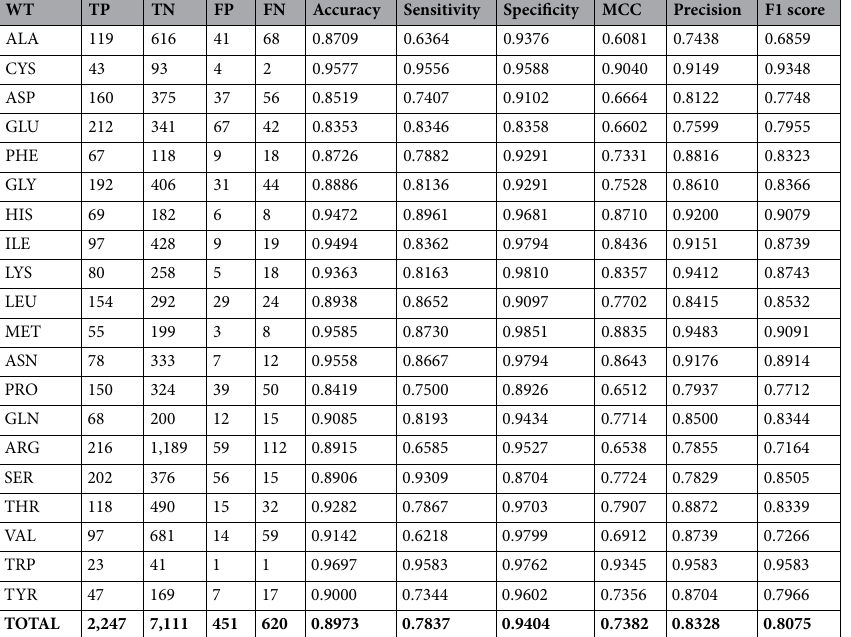
Table 6. The five-fold cross-validation performance values in the training set of the CanSavPre wm system for each wild-type (WT) residue and the total (bolded).